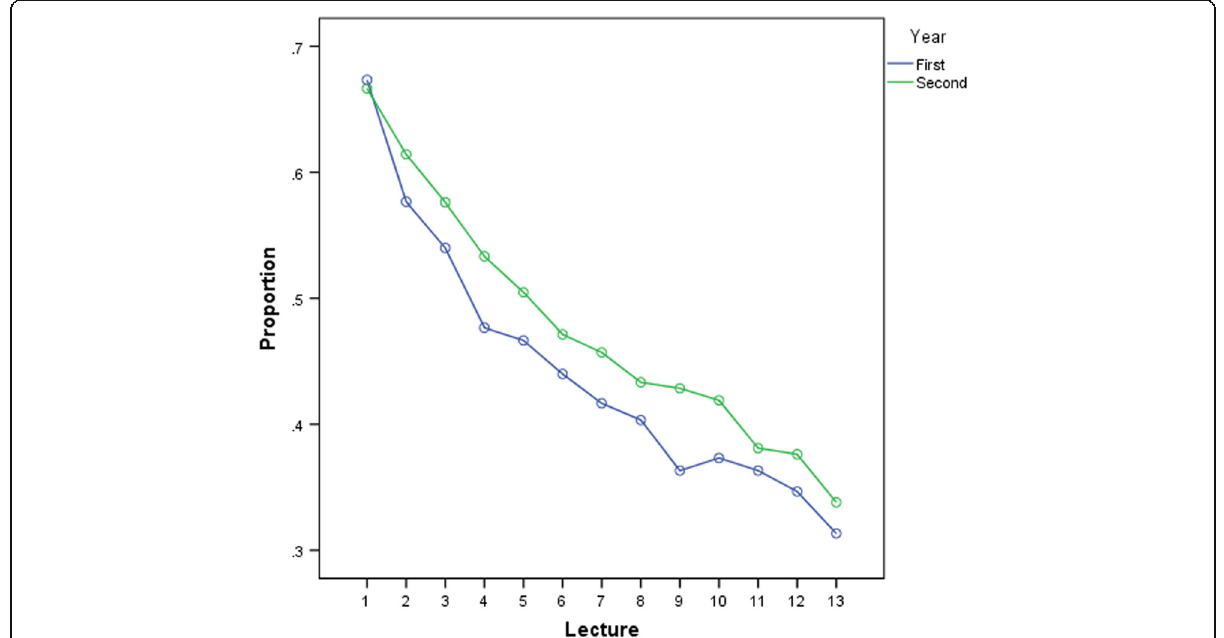
Fig. 2 Submitted reviews of first-year and second-year students across lectures Table 5, only the regression coefficient of advance quiz-